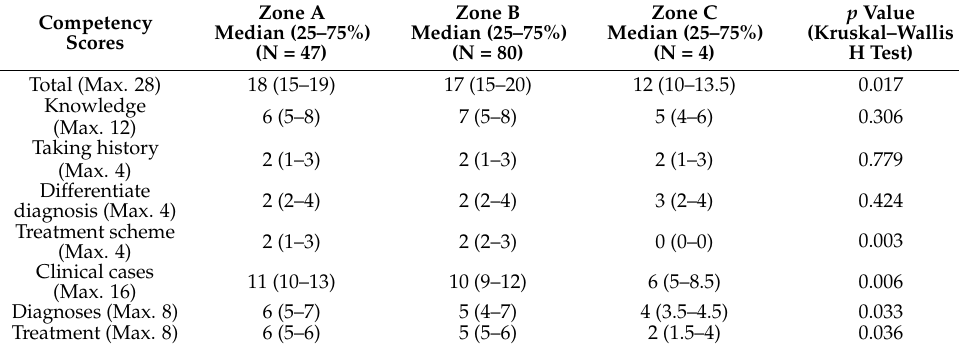
Table 3. Comparison of competency scores among economic zones.